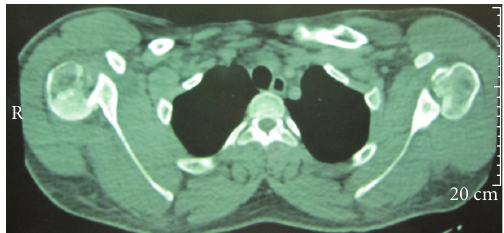
Figure 2: Axial CT scan view reveals bilateral shoulder posterior dislocation with medium defect of articular surfaces (50% in the right, 30% in the left).